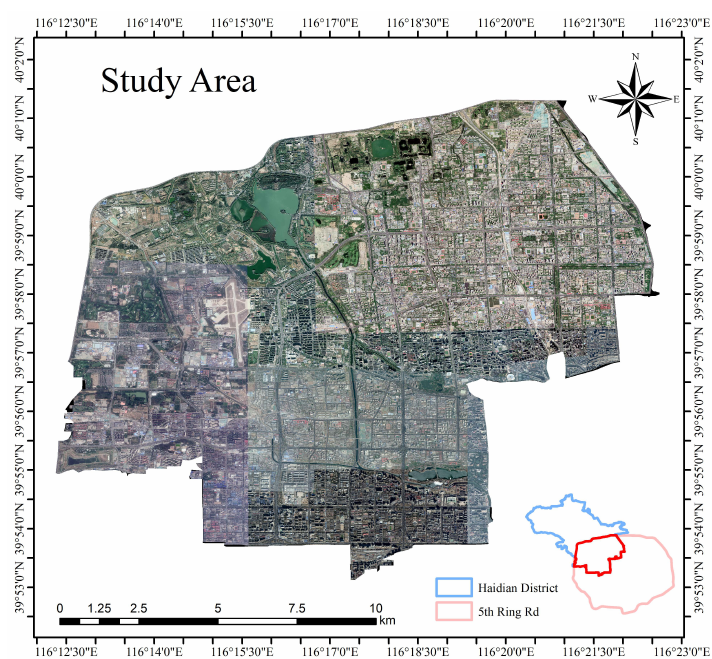
Figure 1. The study area is located within the Fifth Ring Road of Haidian District, Beijing.